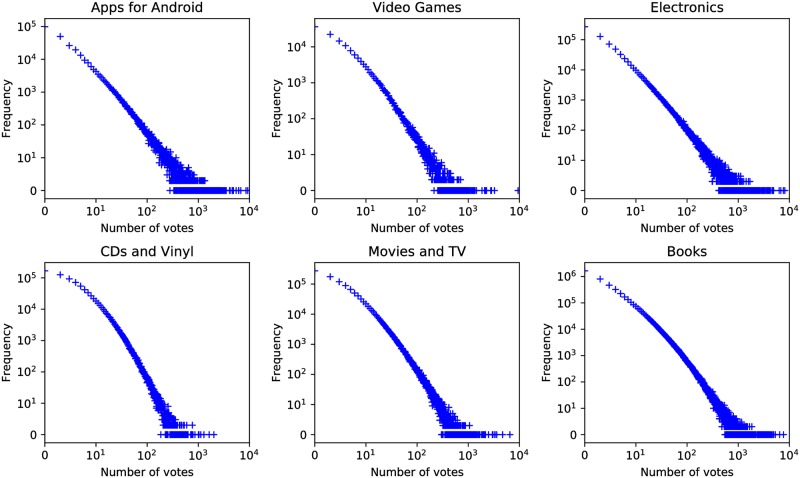
Vote distributions.